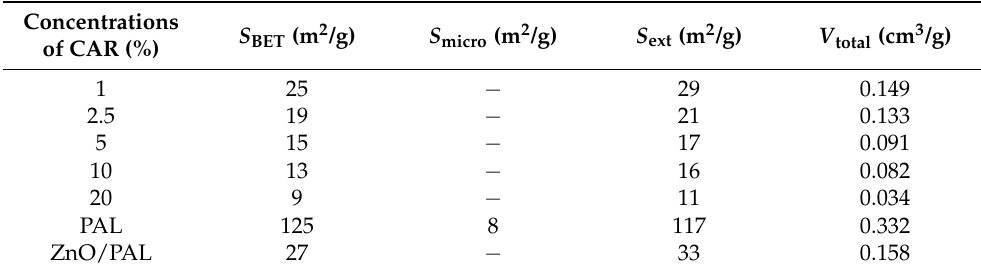
Table 1. S BET , S micro , S ext , and V total of PAL, ZnO/PAL, and ZnO/PAL at different concentrations of